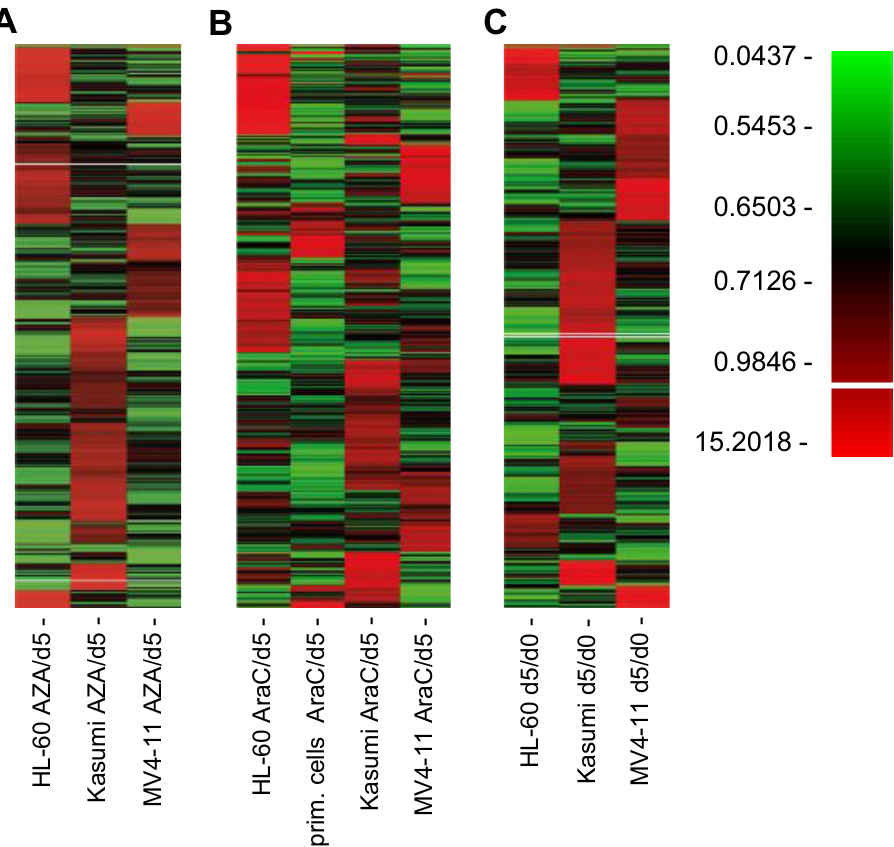
Figure 2. Screening heterogenous cell lines leads to only few potential targets. ( A ) Heatmap showing the alterations of representation of 27,500 shRNAs in HL-60, Kasumi-1 and MV4-11 exposed to sublethal concentrations of azacytidine (AZA) at day 5. ( B ) Heatmap showing the alterations of representation of 27,500 shRNAs in HL-60, Kasumi-1, MV4-11 and primary human blasts exposed to sublethal concentrations of cytarabine (AraC) at day 5. ( C ) Heatmap depicting changes in representation of 27,500 shRNAs over the course of 5 days in HL-60, Kasumi-1 and